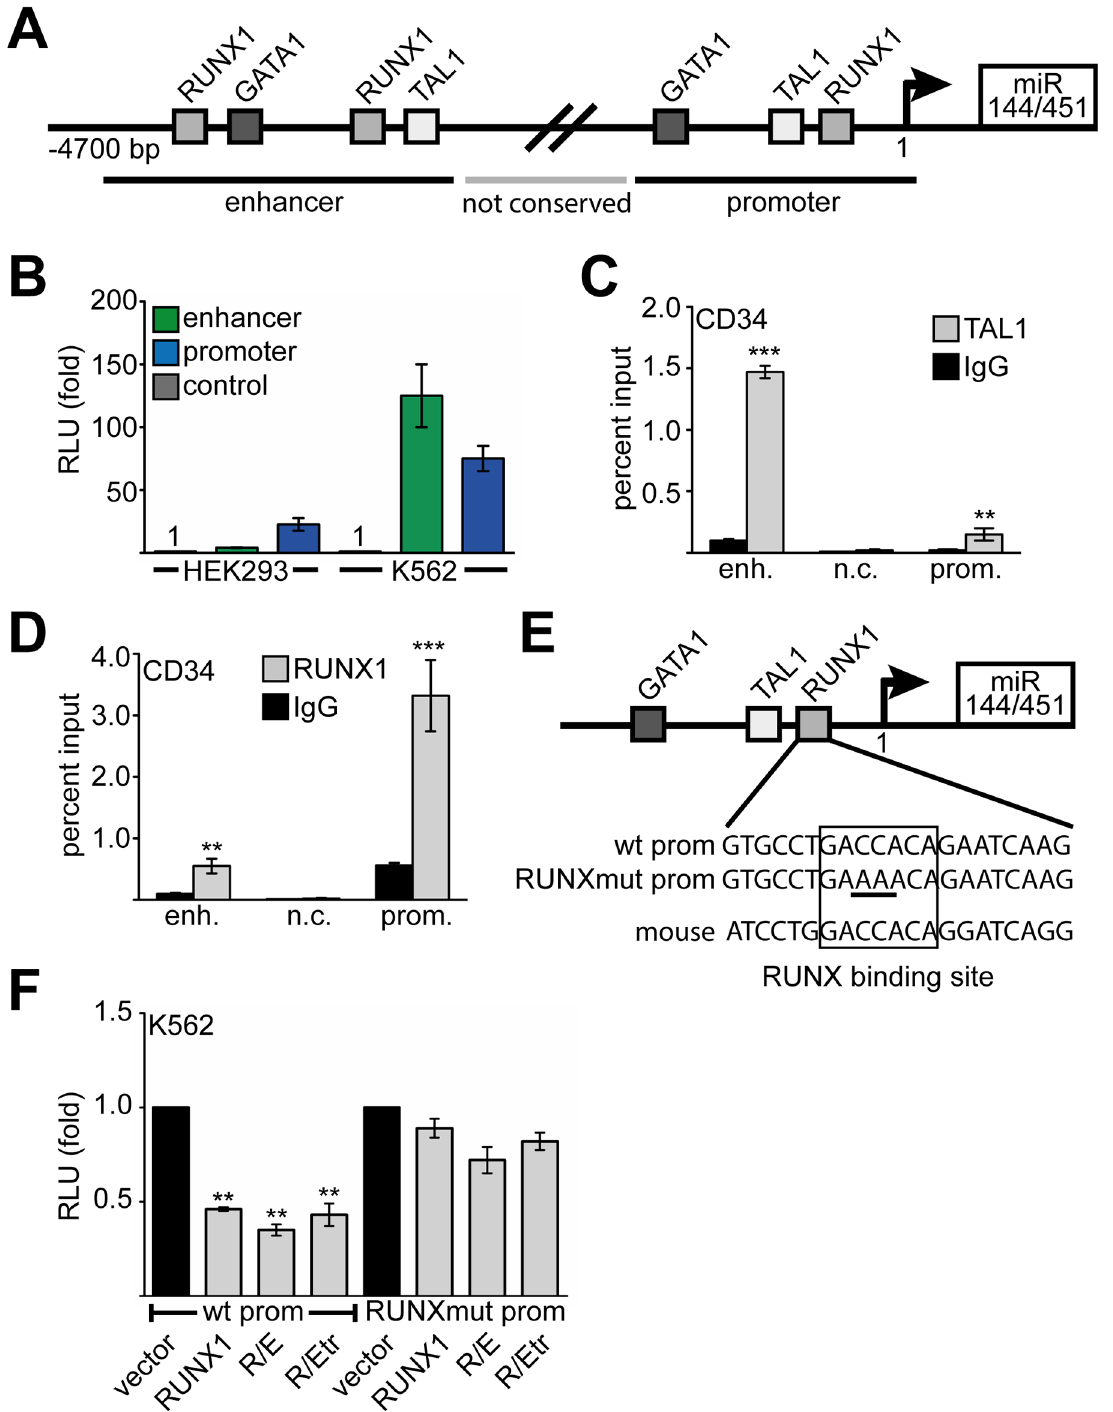
Fig 2. Regulation of miR144/451 expression. (A) Schematic representation of the miR144/451 locus. The first 4700 bp of the 5 ’ -region of miR144/451 are shown. Binding sites for hematopoietic transcription factors are found about 4500 bp upstream (enhancer) and in the proximal promoter region (promoter). A less conserved region (not conserved, n.c.) separates these regions. (B) Luciferase reporter gene experiment with constructs harbouring the enhancer or the promoter region of the miR144/451 cluster. Reporter constructs were transfected into HEK293 cells or K562 cells, respectively. Relative light units (RLU) are given as fold induction compared to values gathered with empty luciferase vector. Luciferase values were normalised for transfection variations by measuring the activity of a cotransfected beta-galactosidase expression vector. Error bars indicate the standard deviation from six independent transfections and